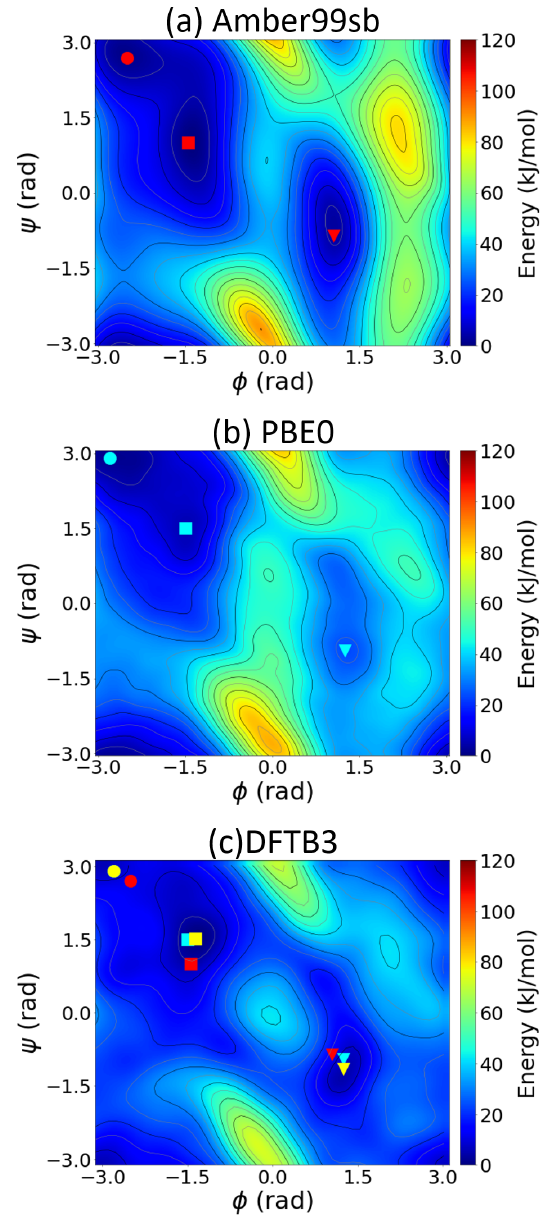
Figure 2. Two-dimensional free-energy surface of alanine dipeptide as a function of the backbone dihedral angles, φ and ψ , obtained from well-tempered metadynamics simulations using ( a ) classical MD with the Amber99sb force field, ( b ) DFT-PBE0 calculations, and ( c ) SCC-DFTB3 calculations. The red, cyan, and yellow points in panels ( a – c ) represent the local minima obtained using the Amber99sb force field, PBE0, and SCC-DFTB3, respectively. ● , ■ , and ▼ denote the β , C 7 eq , and C 7 ax minima/metastable structures,